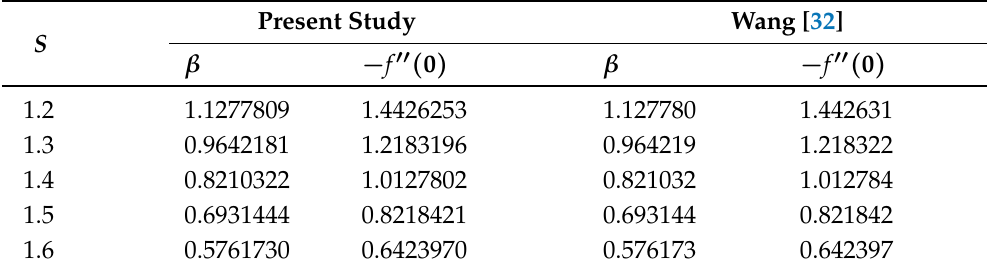
Table 4. Validation of numerical results.